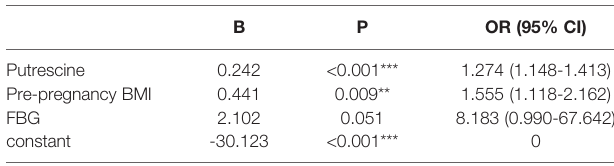
TABLE 4 | Multivariate logistic regression for GDM.